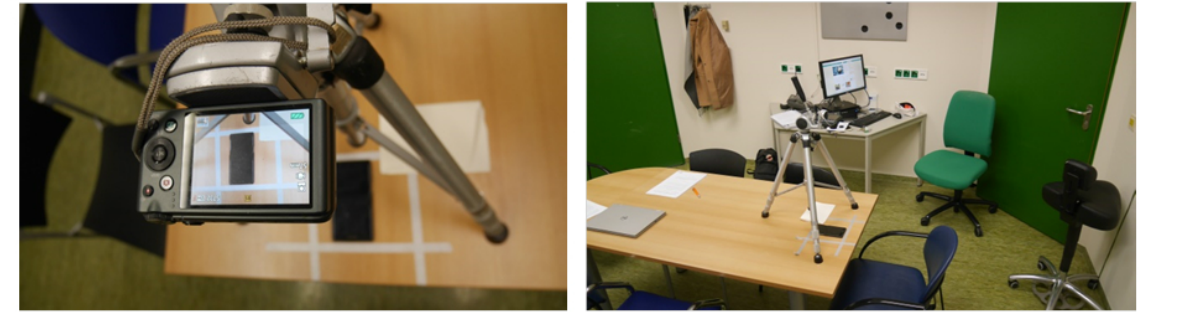
Figure 3. Think aloud session